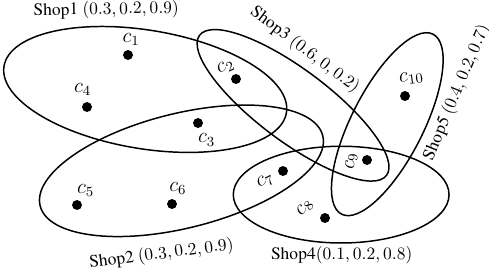
Figure 10. A 6-rung picture fuzzy hypergraph model of express